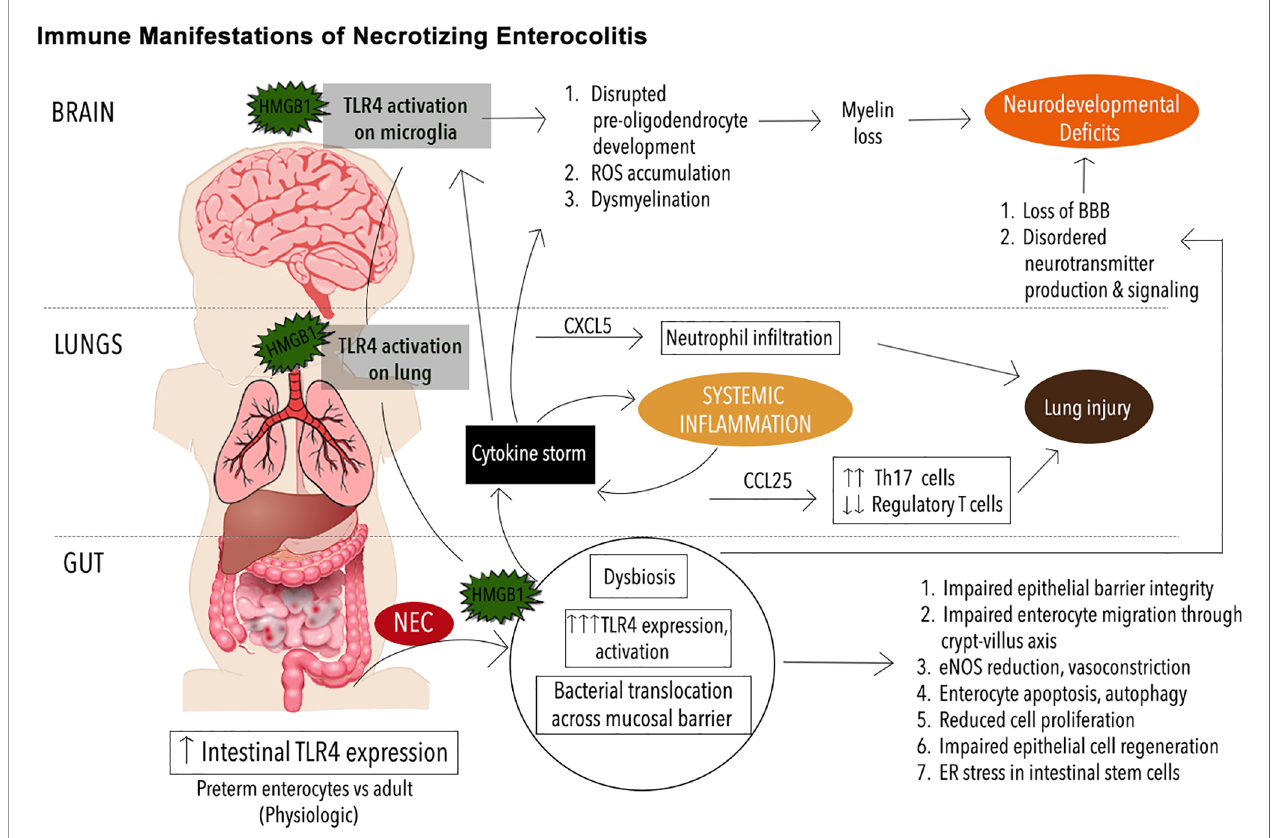
FIGURE 1 | Immune Manifestations in NEC. Schematic illustrating immune signaling involving toll-like receptor 4 (TRL4) in necrotizing enterocolitis (NEC) pathogenesis. The premature immune system leaves the neonate prone to infectious and in fl ammatory diseases such as NEC. Mediated by exaggerated TLR4 signaling on the intestinal epithelium, the onset of NEC leads to mobilization of an endogenous TLR4 ligand, high mobility group box 1 (HMGB1) from the intestine to the lungs and brain where TLR4 activation on the pulmonary epithelium and microglia respectively leads to phenomena such as neutrophil in fi ltration, reactive oxygen species (ROS) buildup, and other downstream effects that exacerbate pathology in the lungs, brain and other organ